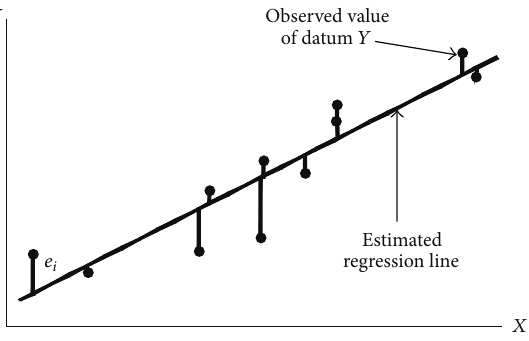
Figure 1: Variance of data from estimated regression